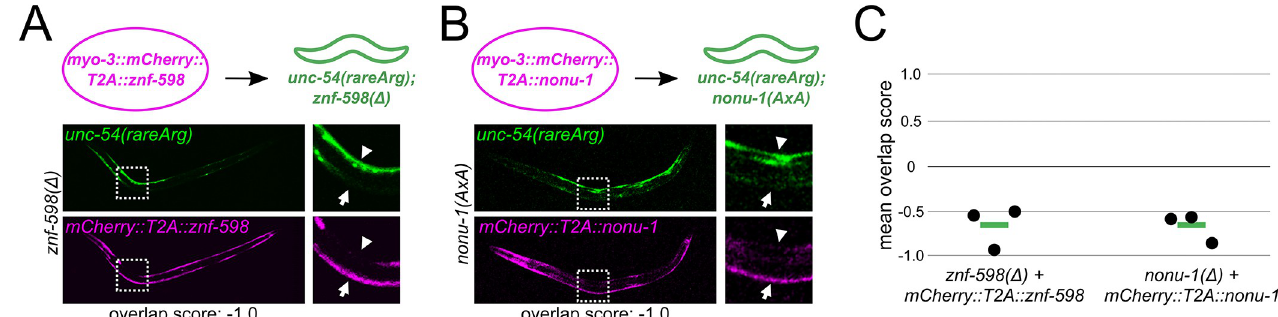
Fig 2. : Cell-specific NGD rescue via overexpression of factors. (A) Schematic of znf-598 construct plasmid and znf-598 strain subject to germline microinjection. Below are GFP and mCherry images of a representative animal expressing the above construct, with a zoom in of an area demonstrating the effect of mCherry-marked factor expression on NGD (GFP). (B) As in (A) for nonu-1 construct in nonu-1 strain. (C) Mean overlap score of strains in (A, B). Each black dot represents the mean of one independent isolate (n � 4 animals/isolate), with the mean of all isolates shown as a green bar.